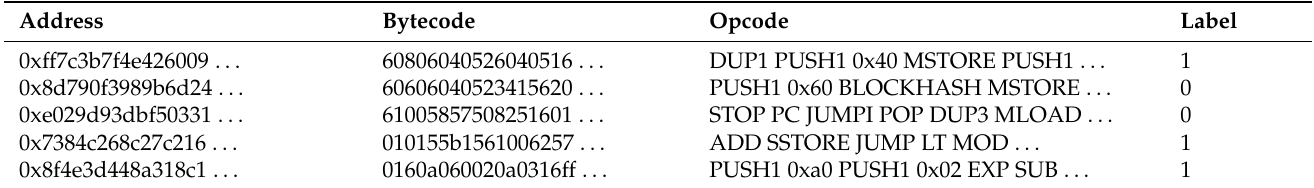
Table 2. Contract address, bytecode, opcode, and label.